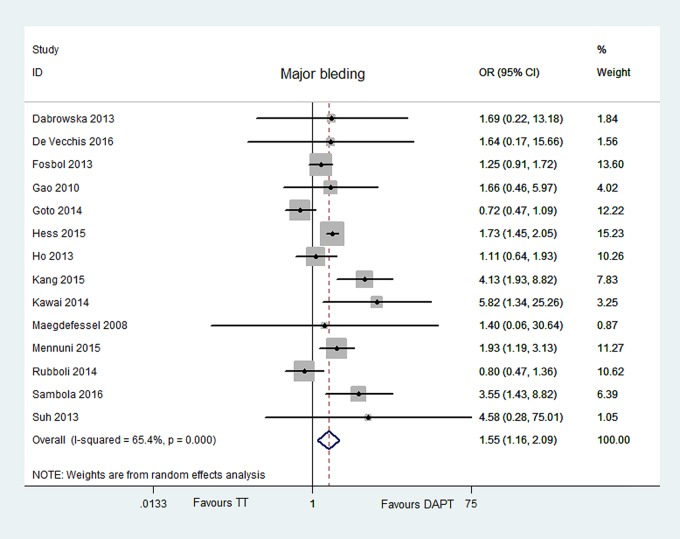
Forest plot of major bleeding in patients with TT vs DAPT.